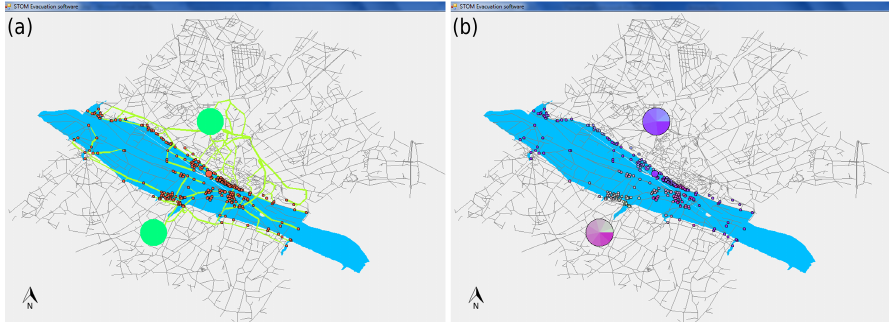
Figure 16. Construction of the evacuation plan at the beginning of the flood: (a) illustrates the three best evacuation paths among buildings and shelters while (b) shows the evacuation of the valley of Gien (each color represents a time